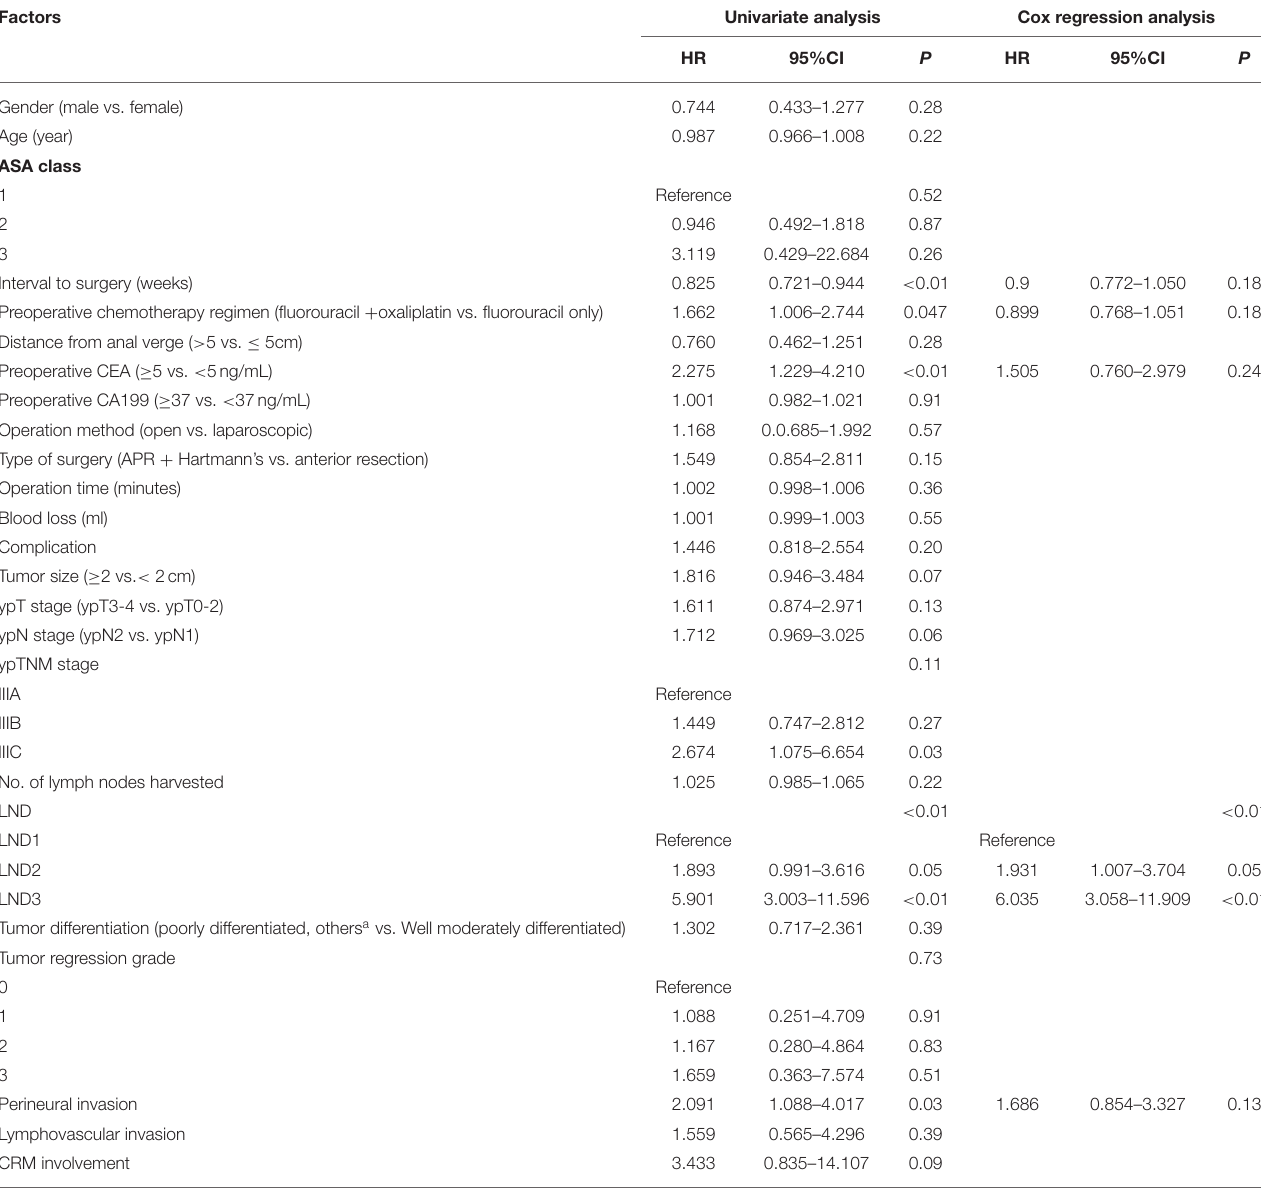
TABLE 3 | Cox regression analysis of factors for 3-year local recurrence-free survival in ypN + rectal cancer patients after nCRT.